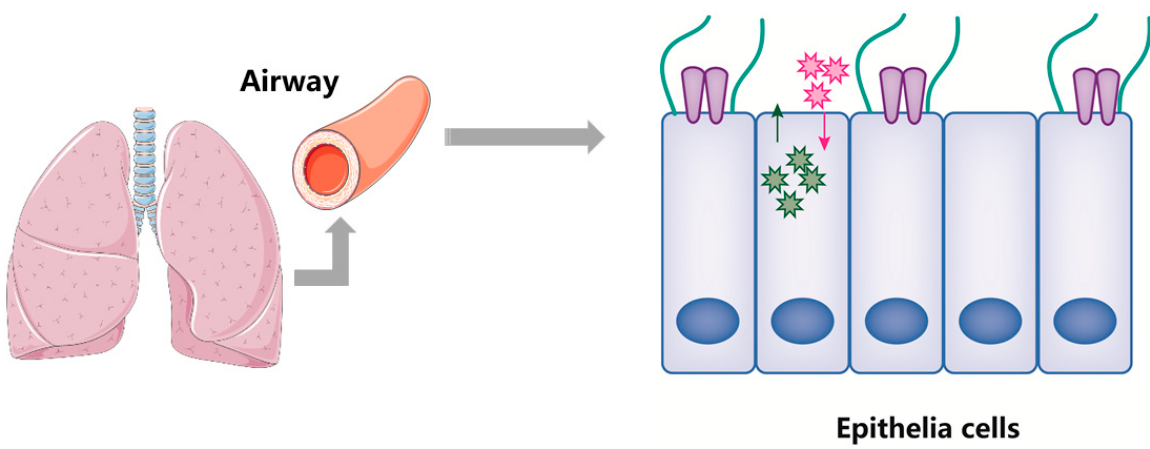
Figure 2. CD73 supports lung tissue-specific homeostasis in epithelial cells to control respiratory functions. CD73 is the primary source of extracellular adenosine on airway epithelial surfaces in the respiratory system. Mucociliary clearance and ion exchange, such as chloride, are both regulated by extracellular adenosine, which also helps to maintain the integrity of the tissue barrier by lowering endothelial permeability. Red and black arrows represent intracellular and extracellular ion ex- change.